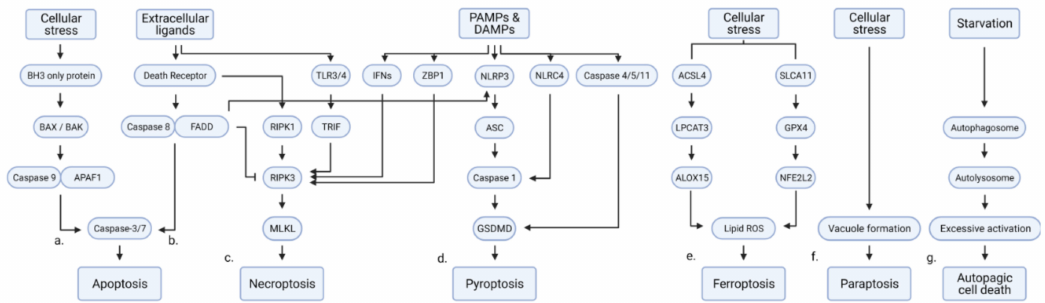
Figure 1. Molecular cascades of regulated cell death. ( a ) Intrinsic apoptosis is induced by cellular stresses, such as growth factor depletion, DNA damage, endoplasmic reticulum (ER) stress, reactive oxygen species generation, replication stress, microtubular alterations, and mitotic defects. ( b ) Extrinsic apoptosis is induced by the activation of death receptors by their cognate ligands. Both apoptotic pathways converge at the activation of caspases, which results in cell shrinkage, membrane blebbing, and DNA fragmentation. ( c ) Necroptosis is mediated by activating RIPK3 and MLKL by death receptors, Toll-like receptors, interferon (IFN) signaling, and ZBP1. The sequential phosphorylation of RIPK3 and MLKL is followed by the oligomerization of MLKL, promoting the formation of pores in the plasma membrane. Therefore, necroptosis results in exposure of cellular materials to the surrounding environment. ( d ) Pyroptosis is induced by detecting damage-associated molecular patterns or pathogen-associated molecular patterns, TAK1 inhibition, and activation of death receptors. These stimuli activate gasdermins and promote pyroptotic cell death, which is characterized by pore formation, cell swelling, DNA fragmentation, and chromatin condensation. ( e ) Ferroptosis is induced by impaired regulation of phospholipid hydroperoxides maintained by system Xc − /GPX. Other mediators of ferroptosis are p53, lipid/iron metabolism, and p62. Ferroptosis is associated with the accumulation of iron, lipid peroxidation, and mitochondria shrinkage. ( f ) Paraptosis is accompanied by ER dilation and mitochondrial swelling. The cells exhibit ER/mitochondrial stress and disrupted proteostasis and ion/redox homeostasis. ( g ) Autophagic cell death is initiated by deregulated autophagic activity. Other types of regulated cell death are excluded in its progression. Excessive autophagy of cellular organelles or the activation of Na + /K + -ATPase results in cell